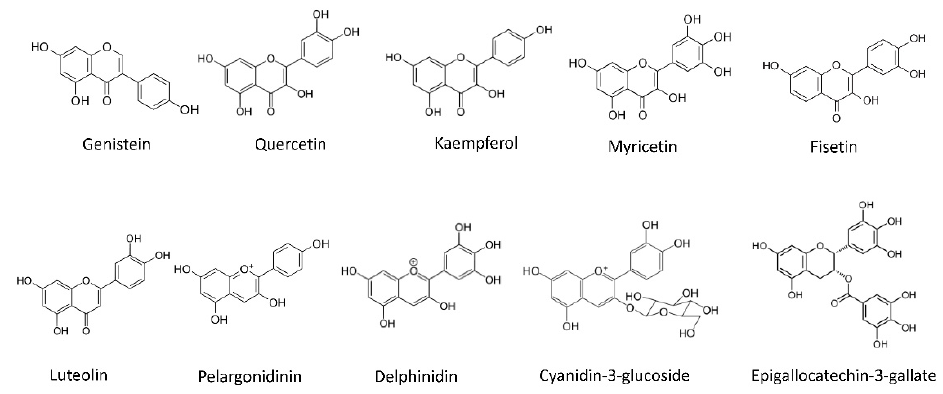
Figure 6. Chemical structures of some flavonoids found in vegetable and fruits, including isoflavones (genistein), flavonols (quercetin, kaempferol, myricetin and fisetin), flavones (luteolin), anthocyanidins (pelargonidin, delphinidin and cyanidin-3-glucoside) and flavan-3-ols (epigallocatechin-3 gallate).